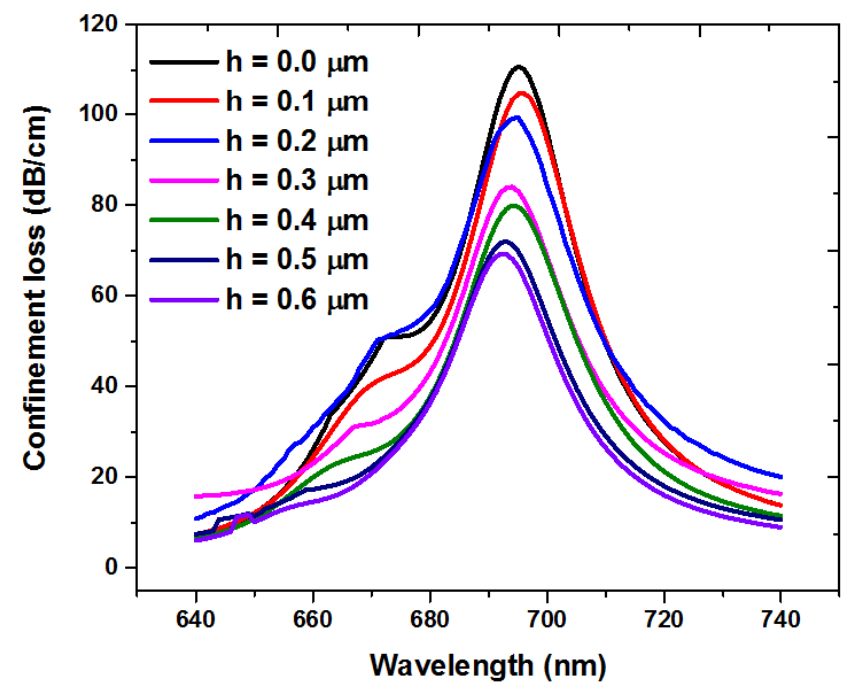
Figure 9. Confinement loss spectra of the core-guided mode for the distance between the top elliptical air hole and the flat surface ( h = 0.1, 0.2, 0.3, 0.4, 0.5, and 0.6 µm).